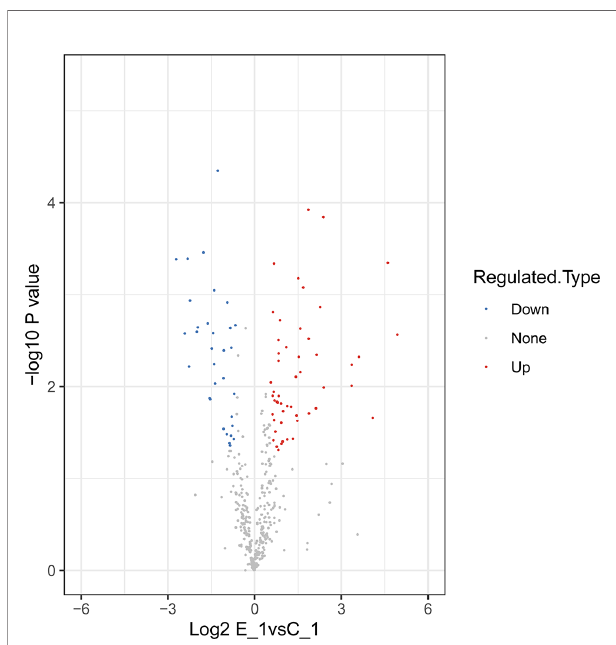
FIGURE 1 | Volcano plots of differentially-expressed proteins.